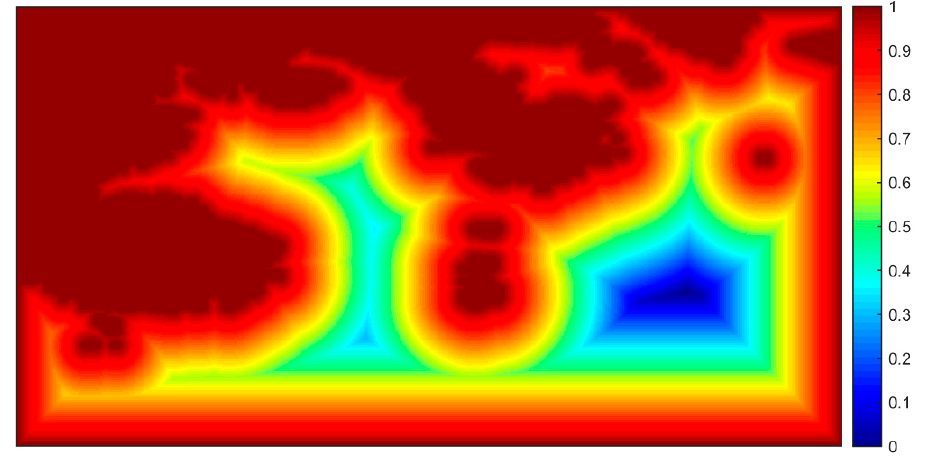
Figure 8. Static environment model representation.